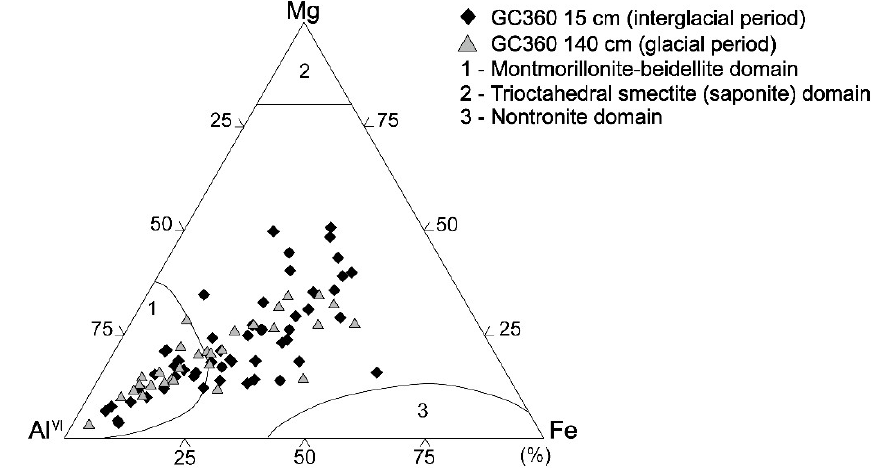
Figure 7. Ternary Al–Fe–Mg plot of the octahedral site compositions of smectites for the glacial (triangle, 140 cmbsf) and the interglacial (diamond, 15 cmbsf) sediments from core GC360. Note that area 1 = montmorillonite-beidellite, area 2 = trioctahedral smectite (saponite), and area 3 = nontronite (Weaver and Pollard, 1973 [2]).